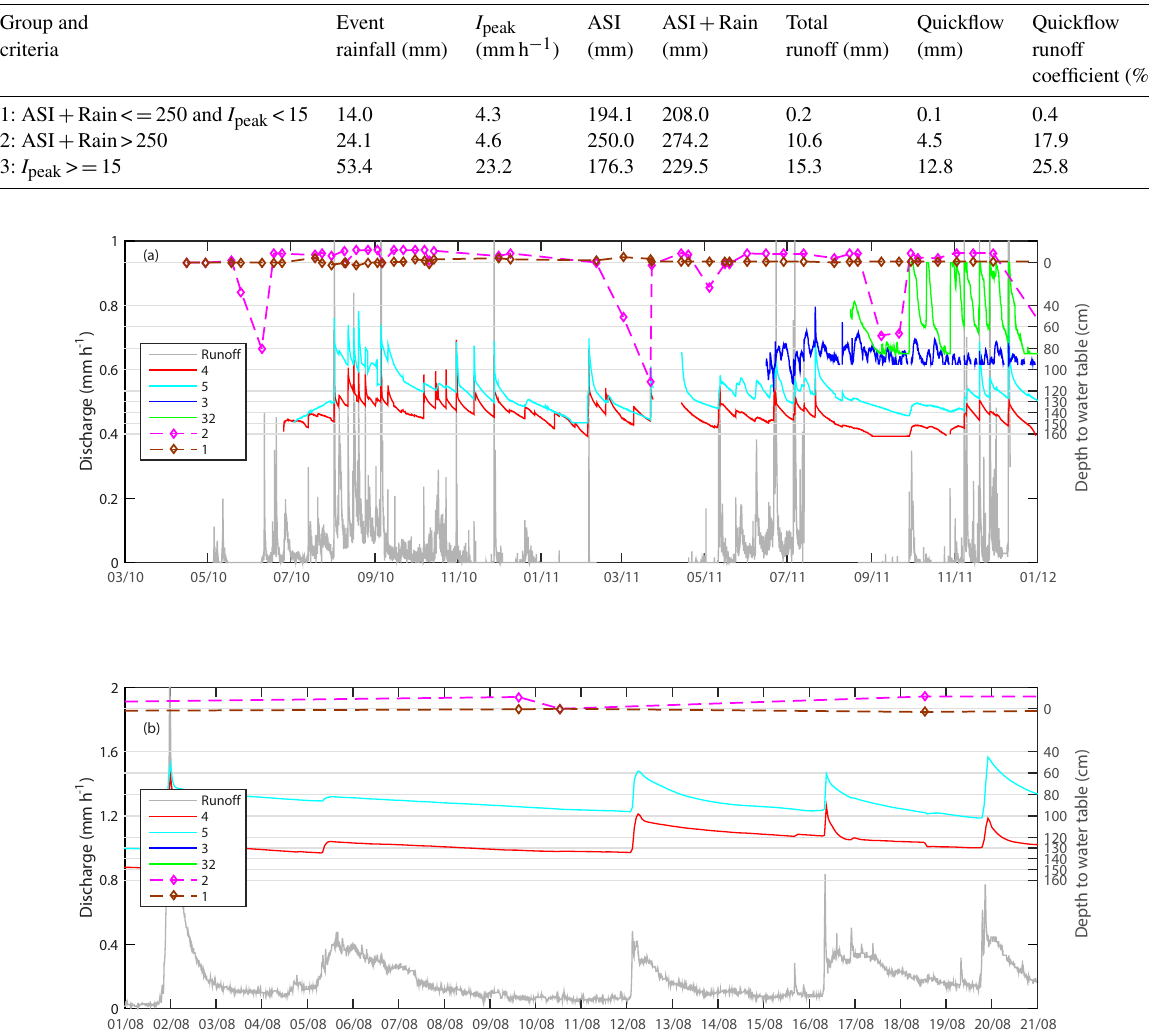
Figure 6. Time series of discharge (grey lines) and groundwater levels at sites 4, 5, 3, 32, 2 and 1; manually read sites are shown with dashed lines and diamonds at measurement points. Levels above zero at sites 1 and 2 occur as the soils are highly pugged in the riparian zone and water pooled on the surface in places, leading to slightly positive water levels being measured, at site 2 in